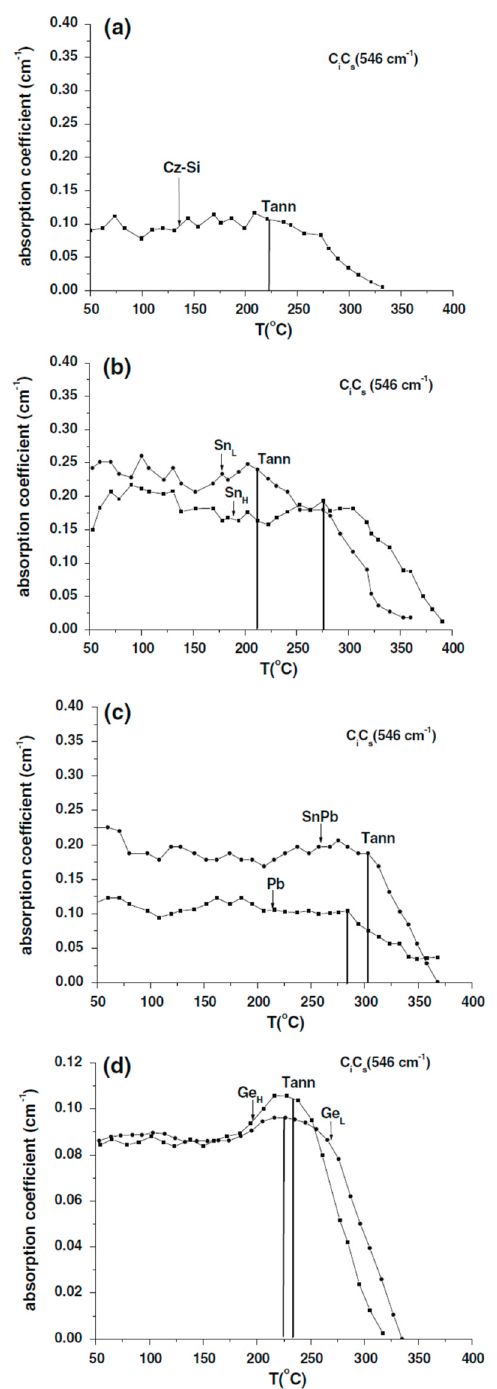
Figure 21. Evolution with temperature of the C i C s defect for various isovalent dopants. For ( a ) Cz-Si, ( b ) Sn L and Sn H , ( c ) SnPb and Pb, and ( d ) Ge L and Ge H Si samples. Reproduced with permission from [158].